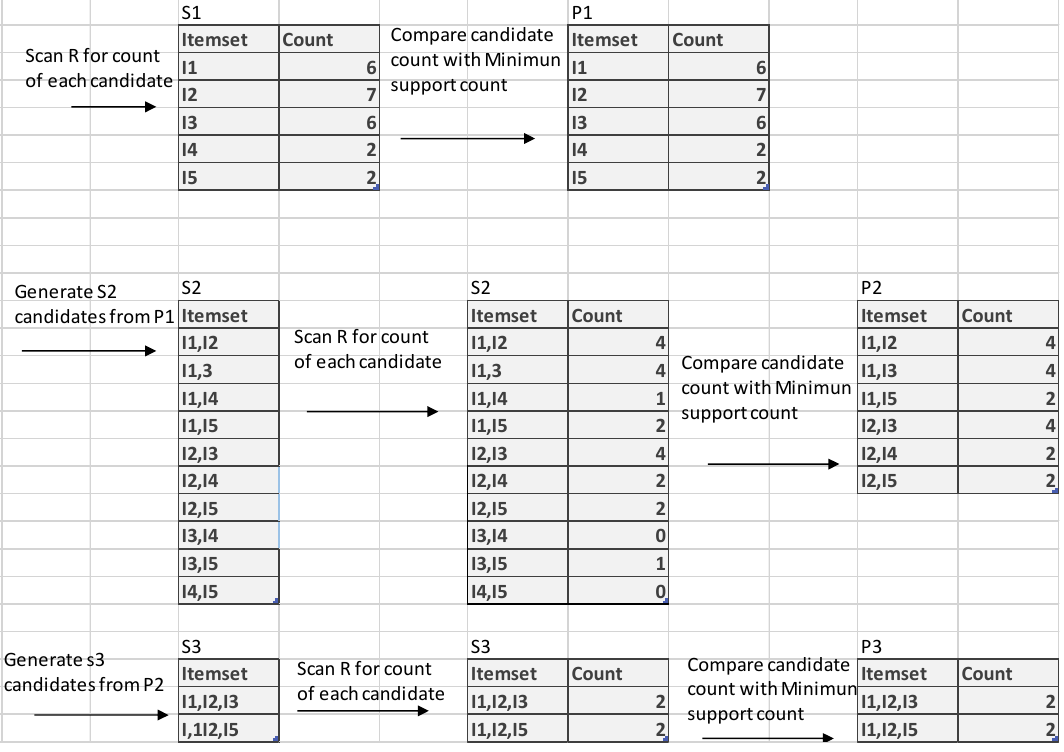
Algorithm 2: movement predicting the future location of a moving object